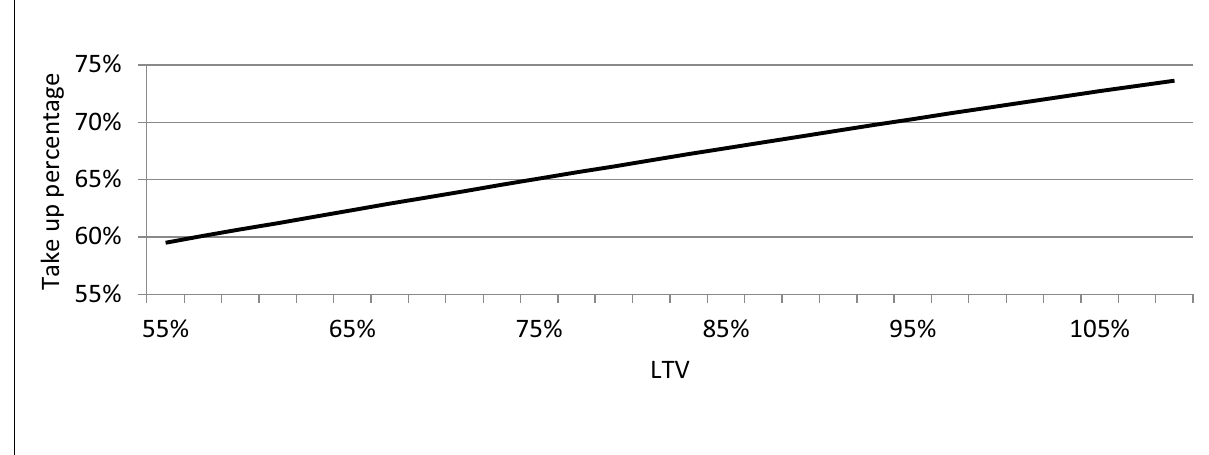
Figure 6: Probability of take-up given the loan-to-value (LTV)